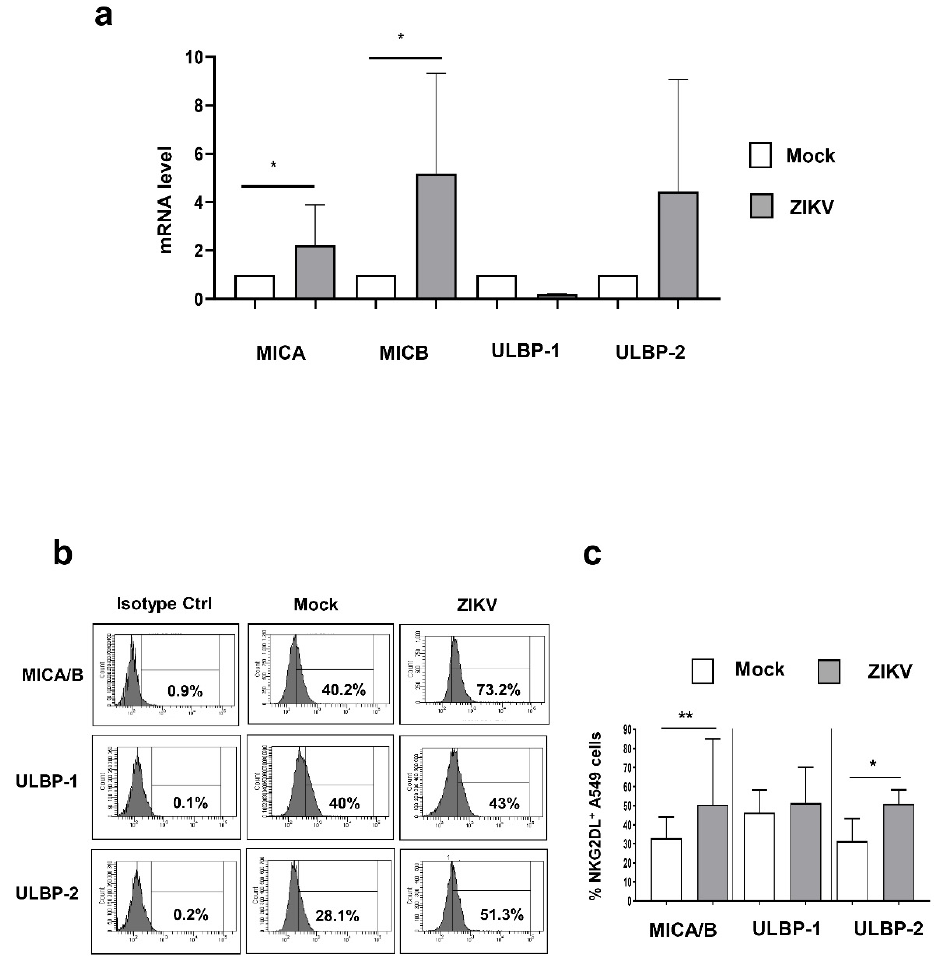
Figure 4. ZIKV up-modulated NKG2DLs in A549 cells. ( a–c ) Expression of NKG2DLs was analyzed in A549 cells infected or not for 48 h with ZIKV (MOI 1). ( a ) Relative NKG2DL mRNA levels in ZIKV-infected cells compared with control mock cells were measured by Real-time qPCR ( n -5). ( b , c ) The frequency of MICA / B + , ULBP-1 + , and ULBP-2 + was measured on mock / ZIKV-infected cells. ( b ) Histograms show MICA / B, ULBP-1, and ULBP-2 expression in a representative experiment. ( c ) Median ± Range of NKG2DL + cells were calculated in 8 independent experiments. Data were represented as median + interquartile range. *: p < 0.05; **: p < 0.01.